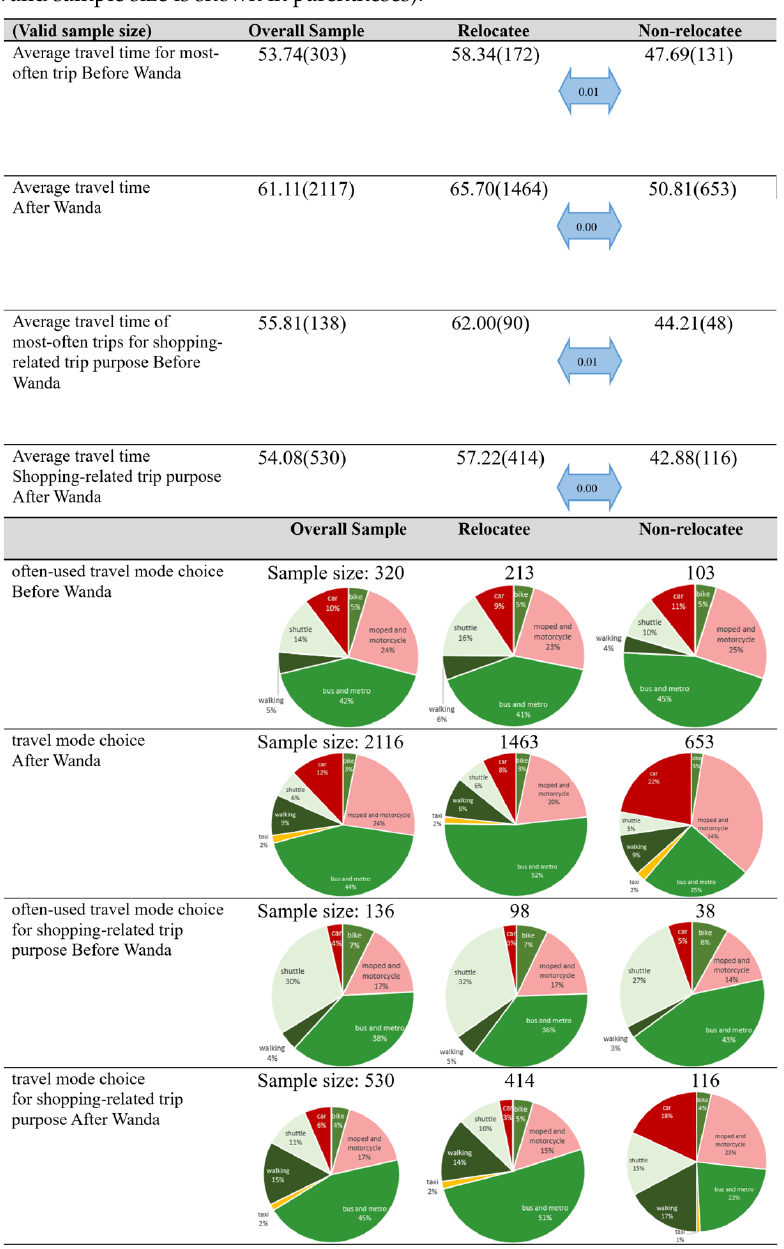
Table 1. Travel time (minutes) and travel mode shares for relocatees, non-relocatees, and overall sample before and after Wanda Shopping Plaza was opened ( p -values are shown in the blue arrows; valid sample size is shown in parentheses).